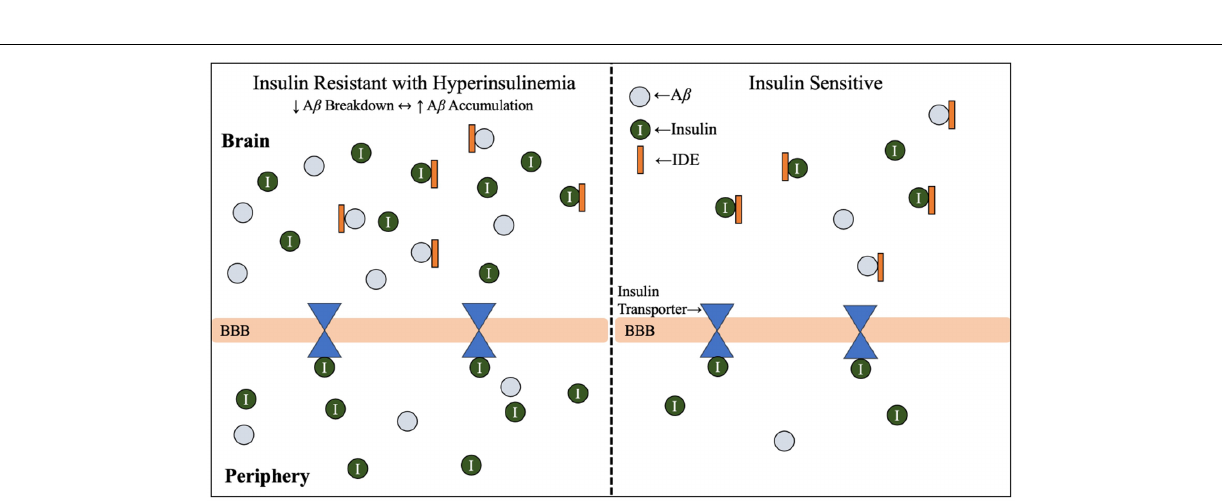
FIGURE 2 | Brain A β accumulation induced by T2D conditions. IDE is responsible for the degradation of excess insulin and A β in the brain. Hyperglycemia, hyperinsulinemia, and insulin resistance are abnormal symptoms present in T2D, and this alteration in metabolism leads to a decrease in IDE expression and increased competition for IDE. Decreased IDE activity and increased IDE competition leads to decreased A β and insulin breakdown. In addition, hyperinsulinemia contributes to a build-up of A β peptides in the brain. Abbreviations: IDE, insulin-degrading enzyme; T2D, type 2 diabetes; A β , amyloid beta.